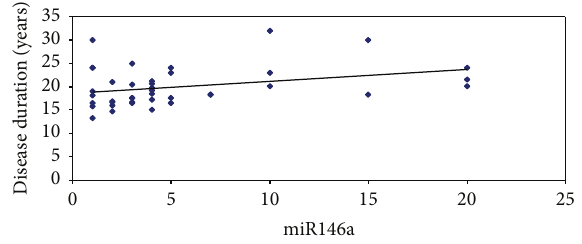
Figure 3: Correlation between miR146a level before treatment and disease duration among all